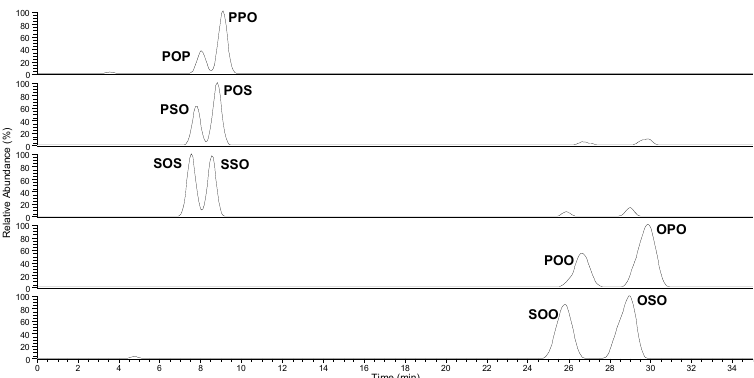
Figure 1. Chromatographic separation of standard TAG (triglyceride) regioisomers visualized at the extracted precursor ion m/z values.